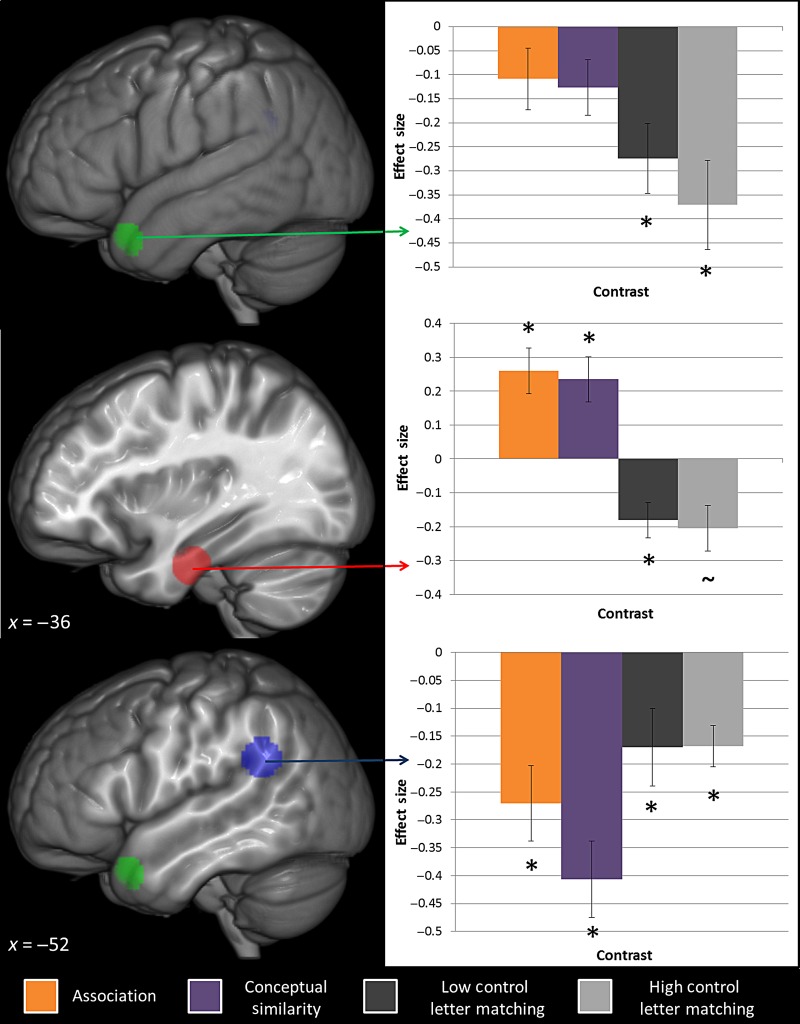
Location and effect sizes of the 3 ROIs. Schwartz et al.'s (2011) aSTS region is shown in green (MNI coordinates = −53 18 −30) with the ventral ATL ROI from Binney et al. (2010) in red (MNI coordinates = −36 −15 −30). Schwartz et al.'s (2011) TPJ ROI is displayed in blue (MNI coordinates = −52 −49 27). The effect sizes of each condition against rest are displayed for each ROI for the conditions associative (red), similarity (green), low control letter matching (light blue), and high control letter matching (dark blue) over rest. Asterisks denote significant contrasts after application of a Bonferroni correction for multiple comparisons (P < 0.05). Tilde denotes a trend toward significance (P < 0.1).